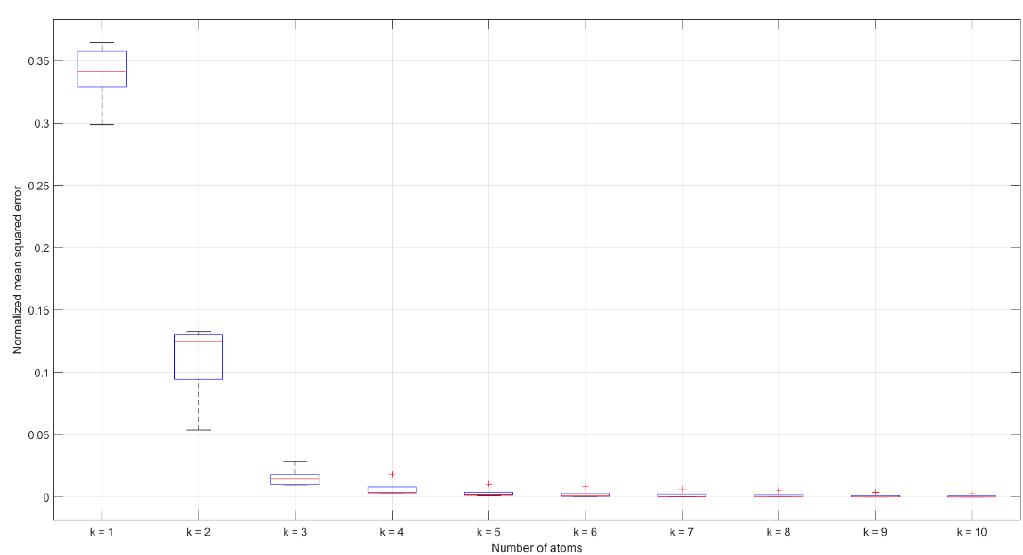
Figure 4. Normalized mean ‐ squared error NMSE.